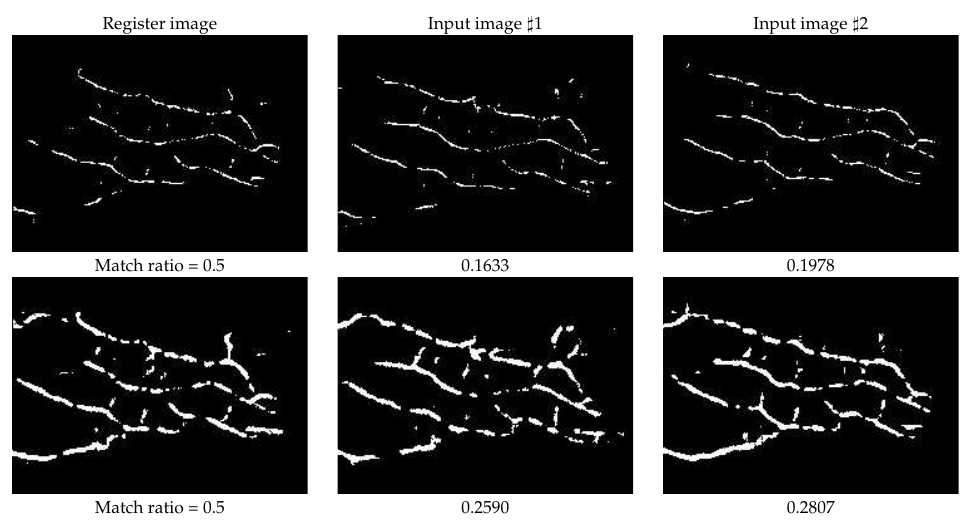
Figure 6. The match ratio of intra-class, that means the registered template and input image are both from the same finger class. The first row shows the results of mean curvature method, and the second row shows the results of our proposed RLF-based method. Their corresponding match ratios are listed below the images.